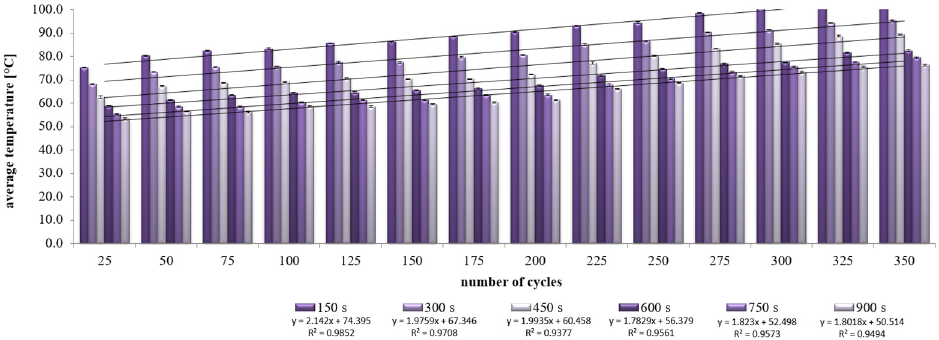
Figure 18. Change in the average temperature of CC-2 concrete during the cooling process. Table 8. Characteristics of the change in parameters of the average temperature of CC-1 and CC-2 concrete during the cooling process.